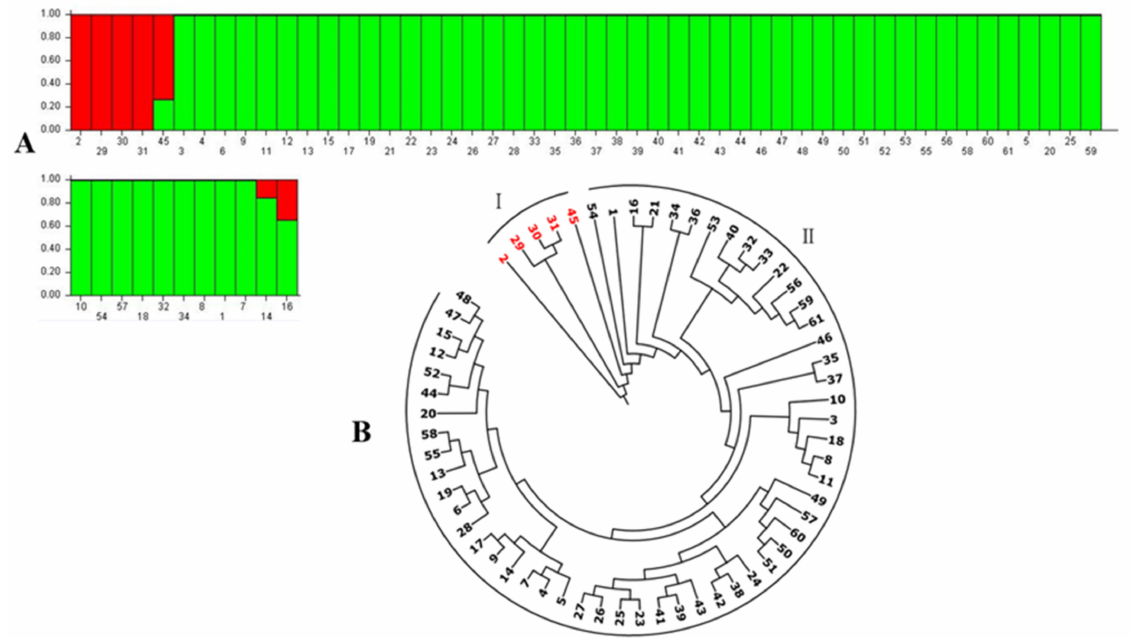
Figure 5. The genetic diversity of the 61 accessions based on SSR markers. ( A ) Population structure of 61 accessions in C. pepo by the model-based analysis. The scale of the y -axis represents the percentage of genetic components, and the x -axis represents the different materials. ( B ) Phylogenetic tree of 61 accessions in the C. pepo by UPGMA analysis; Group I (red makers) and Group II correspond to the structure